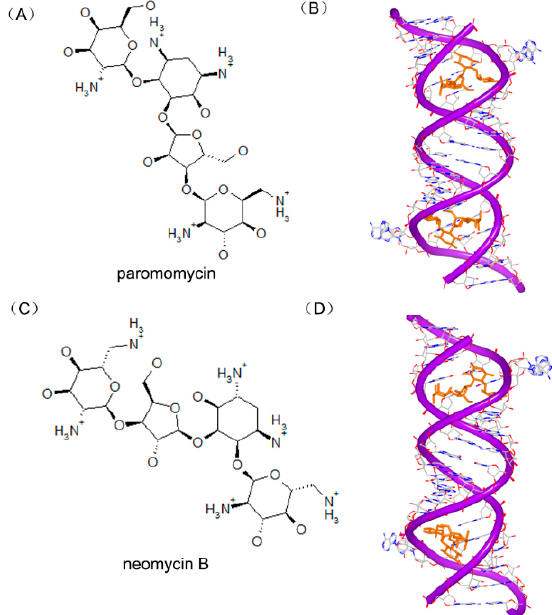
Figure 22. ( A ) Chemical structure of paromomycin; ( B ) complex of a RNA duplex with paromomycin (PDB code: 1J7T); ( C ) chemical structure of neomycin B; and ( D ) complex of a RNA duplex with neomycin B (PDB code: 2ET4). The orange structure represents the small molecule; the purple structure represents the backbone of nucleic acid; the blue and red atoms in the molecule represent nitrogen and oxygen atoms,